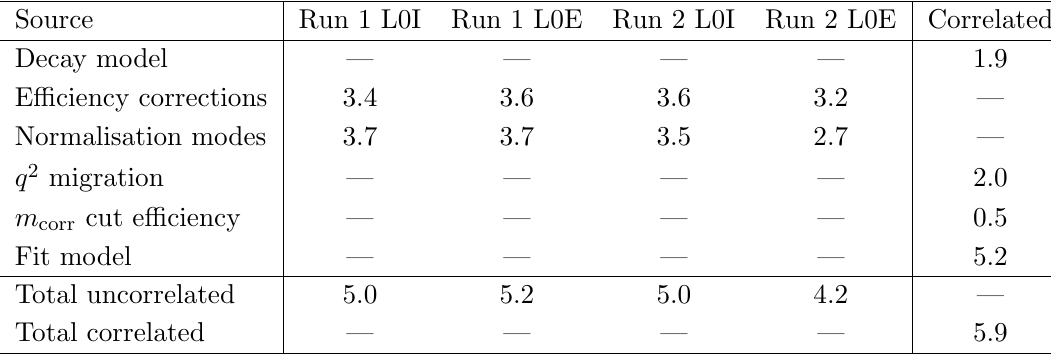
, for the pK (cid:1) (cid:2) 10 (cid:0) 7 (cid:0) 0 : 23